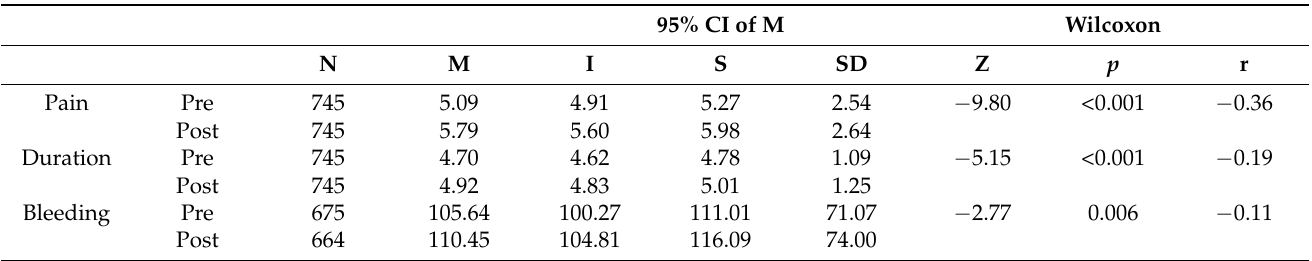
Table 3. Number (N), Mean (M), Inferior (I) and Superior (S) Confidence Interval of the Mean (95%), Standard Deviation (SD) of pain, duration and bleeding and contrast by moment (pre vs. post).